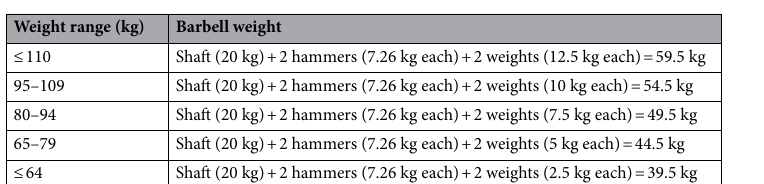
Figure 2. The electrode application site for electromyography. ( a ) medial view of the lower leg, ( b ) anterolateral view of the lower leg, ( c ) anterior view of the upper leg, ( d ) posterior view of the upper leg, ( e ) anterior view of the abdomen, ( f ) posterior view of the lower back. A: Tibialis posterior, B: Abductor hallucis, C: Peroneus longus, D: Tibialis anterior, E: Rectus femoris, F: Semitendinosus, G: Biceps femoris long head, H: Internal oblique, I: Multifidus, J: Gluteus maximus.